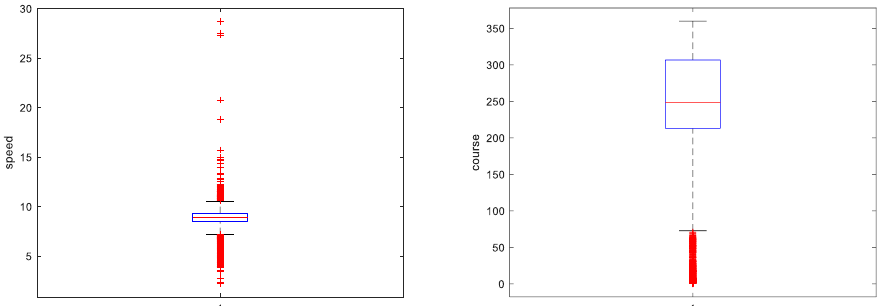
Figure 8. Distribution of speed and course.